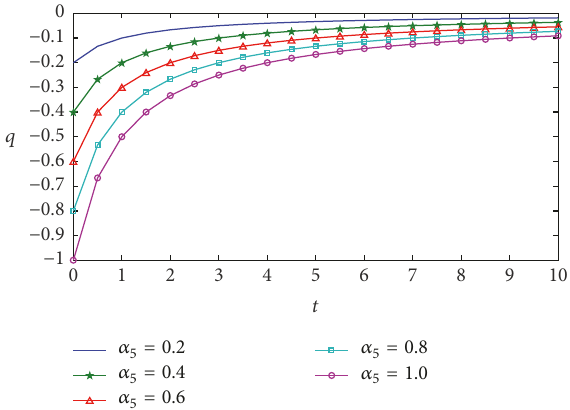
Figure 18: Variation of deceleration parameter against time for different 𝛼 5 .